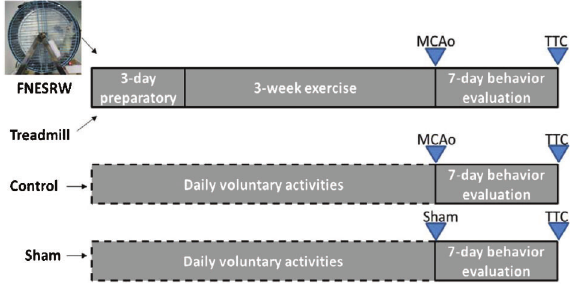
Figure 1. Timeline of the experimental design. Only the forced non-electric-shock running wheel (FNESRW) and treadmill groups followed 3 weeks of running training, and only the sham group was not triggered by middle cerebral artery occlusion (MCAo). All animals were observed for 7 days using a behavior